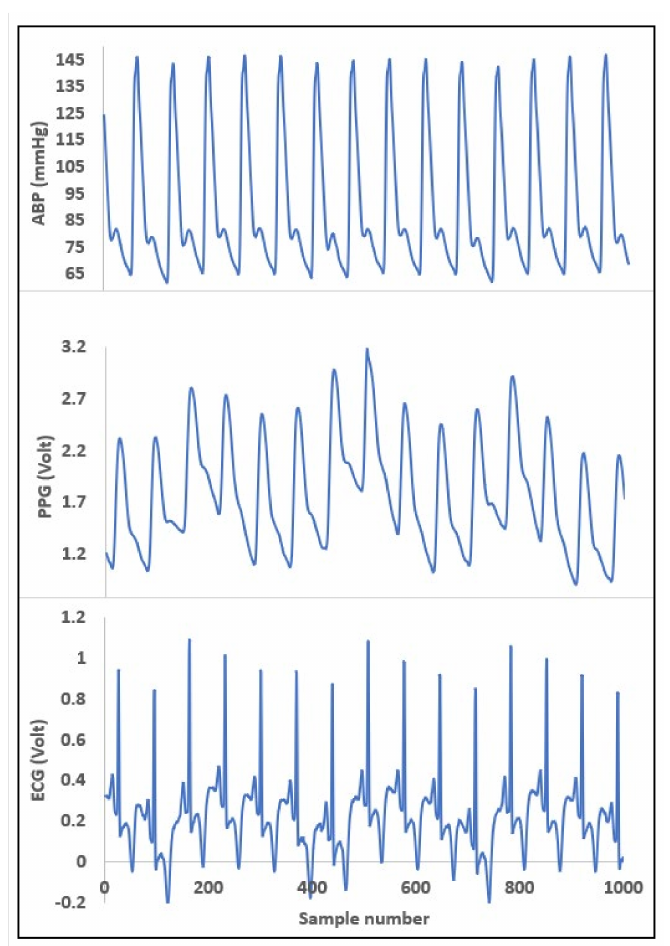
Figure 12. Example of a raw data from a patient with first 1000